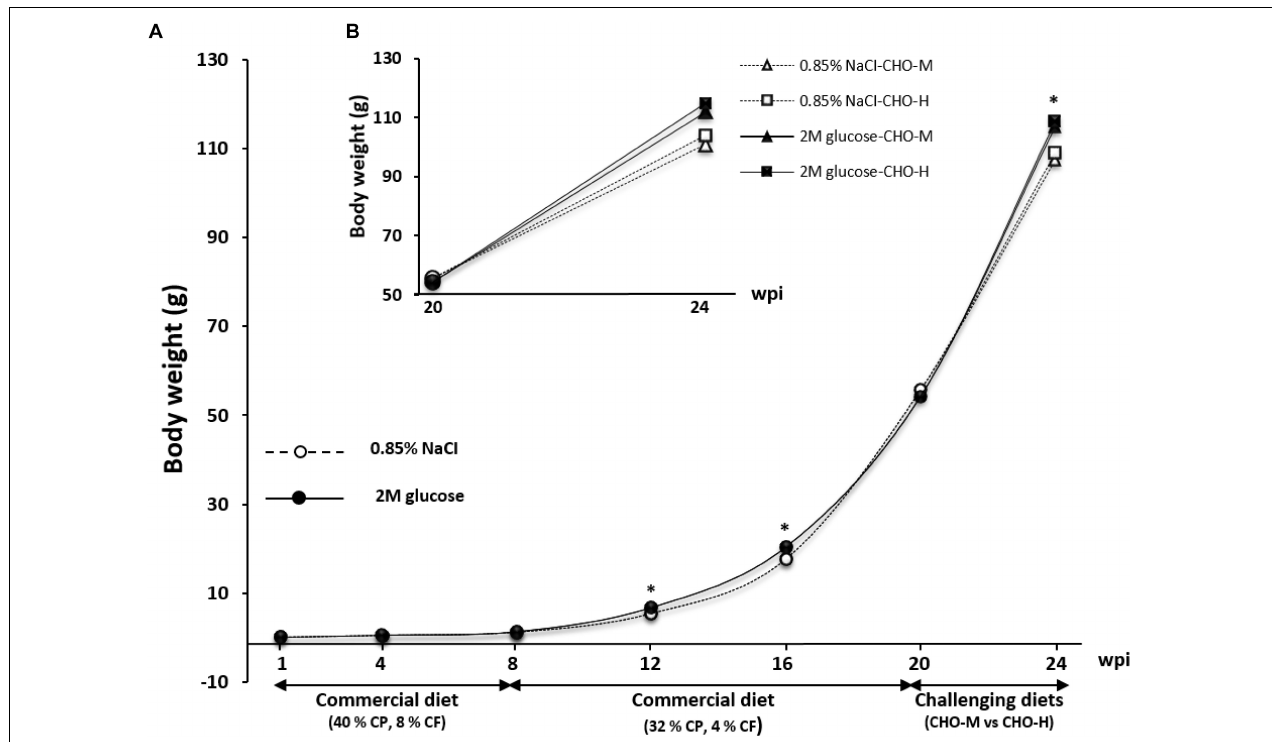
FIGURE 3 | Growth response of fish injected with saline (0.85% NaCl) and glucose (2 M) during 1–24 wpi. Experimental fish were fed with commercial diets during 1–20 wpi. The asterisk indicates significant differences ( P < 0.05) between fish injected with saline (0.85% NaCl) and glucose (2 M) at 12 and 16 wpi. The fish